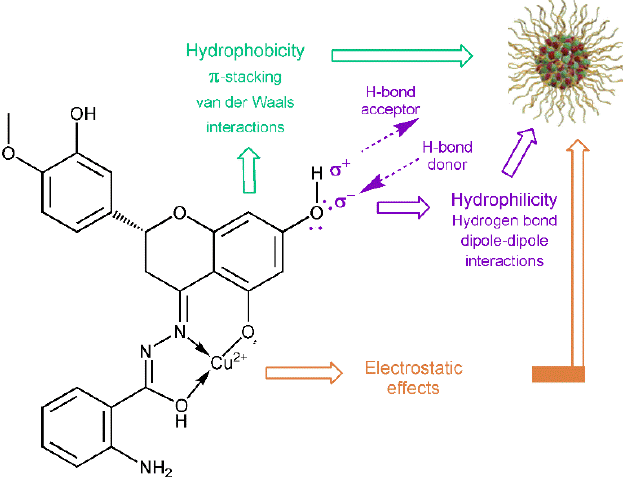
Figure 7. Proposed interactions of CuHABH complex with bacteria.